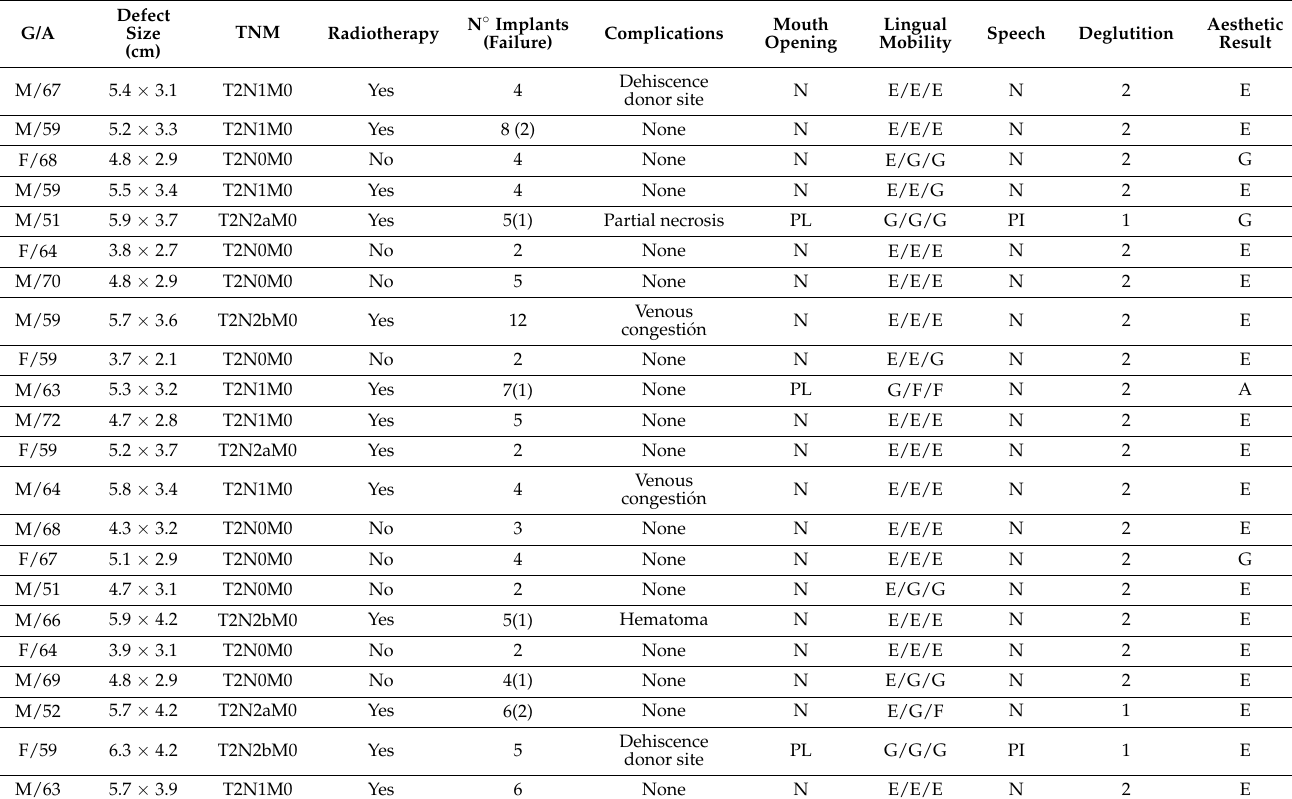
Table 1. SCCA of tongue and floor of the mouth reconstructed with FAMM flap and dental